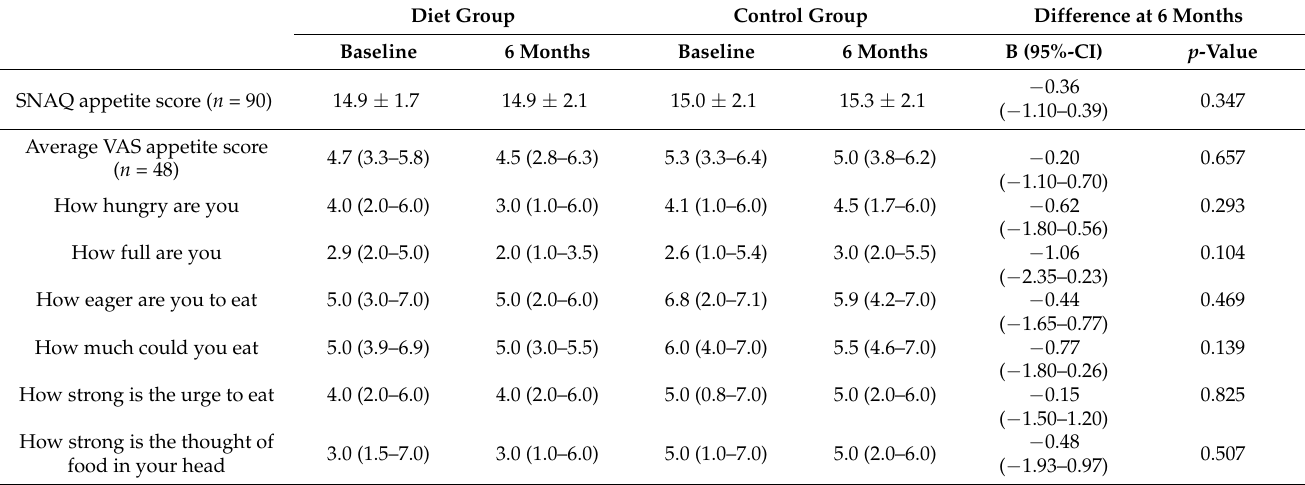
Table 3. Appetite measures at baseline and after 6 months in the intervention and control